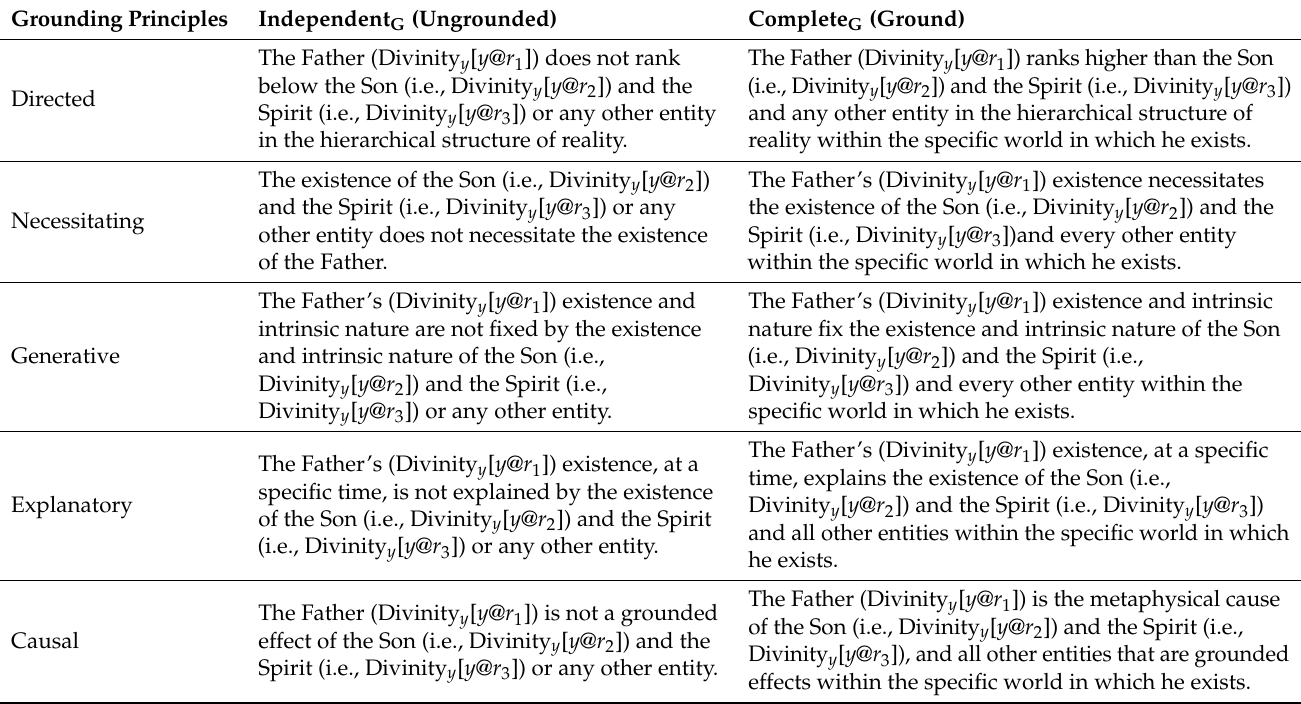
Table 2. Trinitarian Fundamentality Grounding